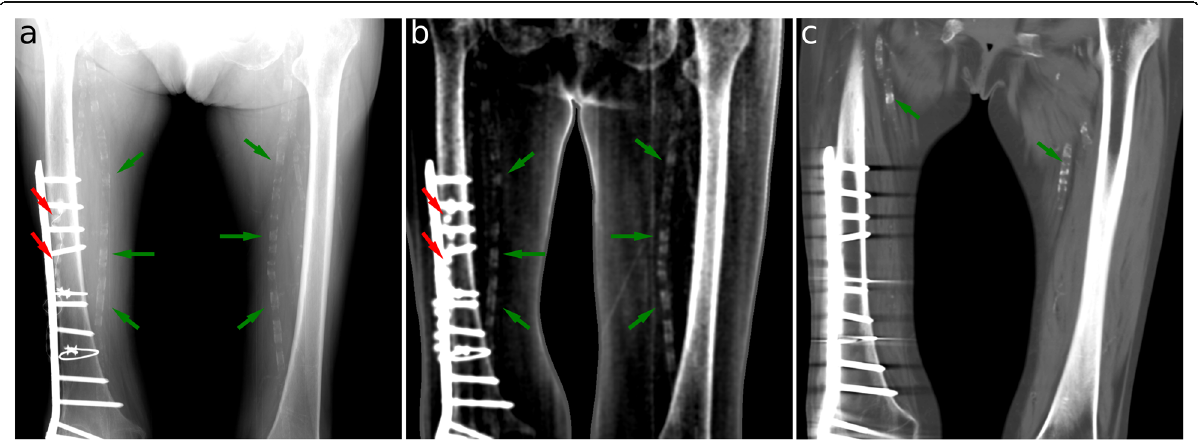
Fig. 3 X-ray attenuation (window level 2.45, window width 1.9) ( a ), dark-field (window level 0.4, window width 2.0) ( b ) radiographs, and a computed tomography reconstruction ( c ) of the upper legs. The metal screws and plate on the right femur, a fixation of an old fracture, are clearly visible in all three modalities. Near the screws, an antibiotic bead chain is also visible in the attenuation and dark-field images (red arrows). Furthermore, calcifications are visible within the superficial femoral arteries in both thighs at all three modalities (green arrows)